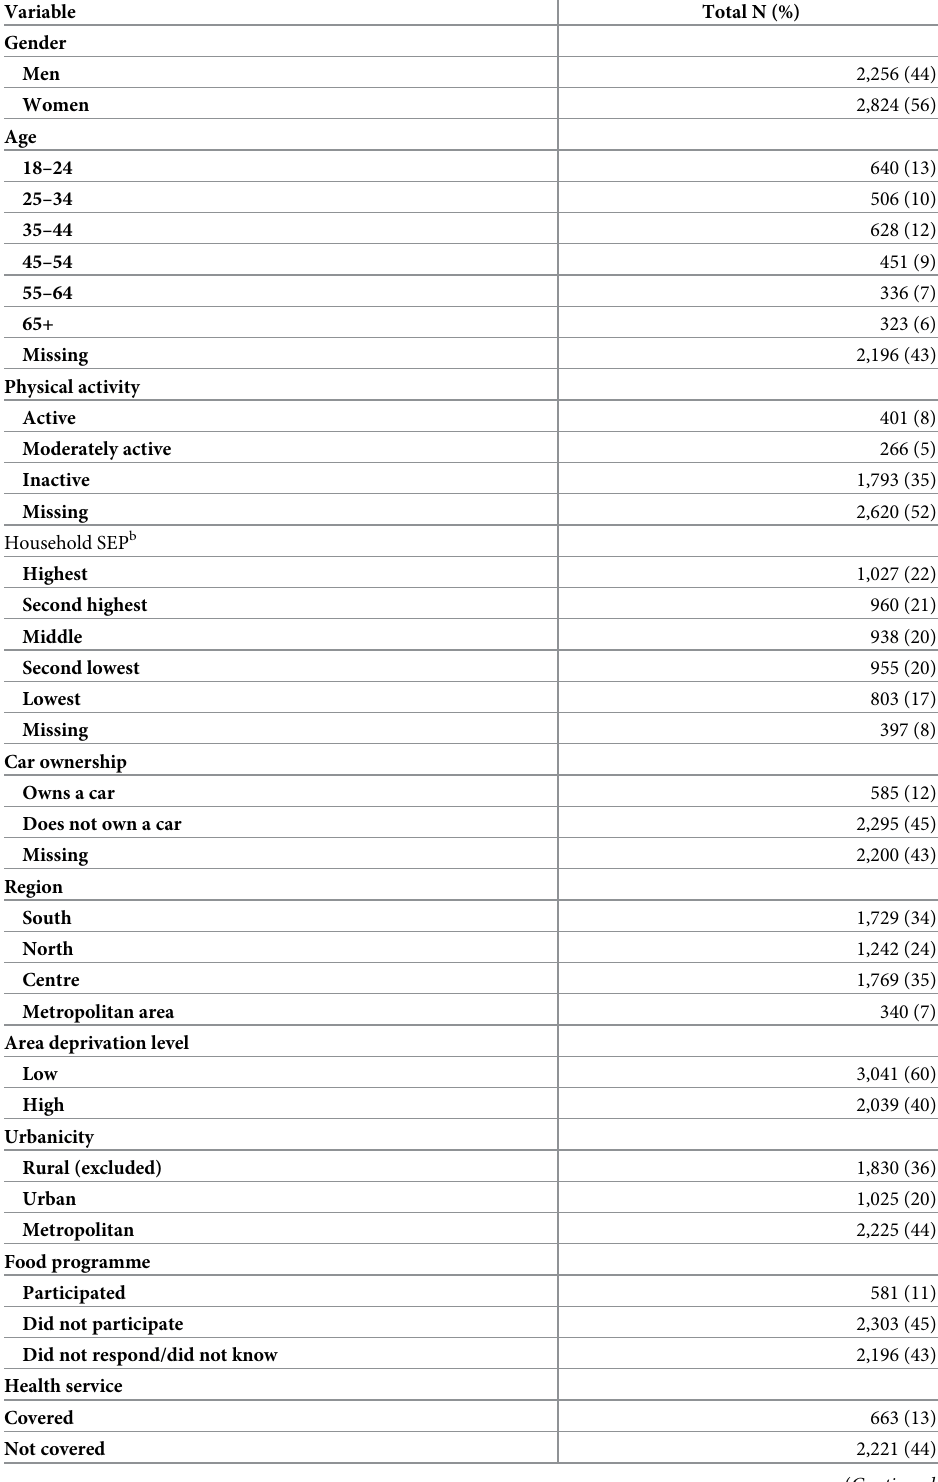
Table 2. Sociodemographic, and economic characteristics of Mexican adults aged 18+ inhabiting urban areas of Mexico a